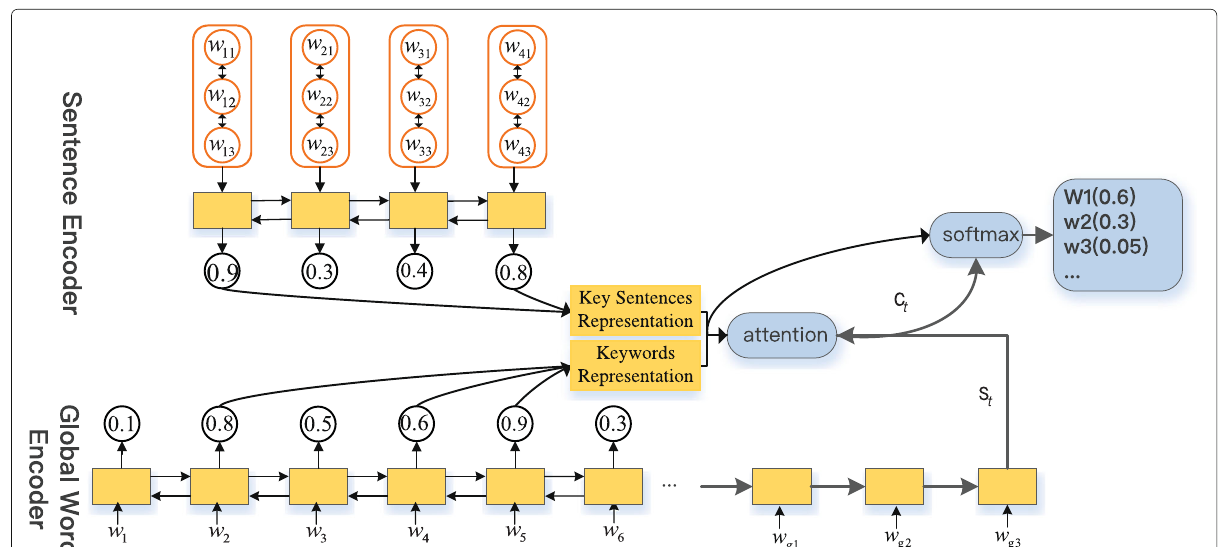
Fig. 2 Architecture of the document encoder and key information extraction. The document encoder includes a global word encoder and a sentence encoder. Key information extraction consists of keyword extractor and key sentence extractor, and then two kinds of key information representation are